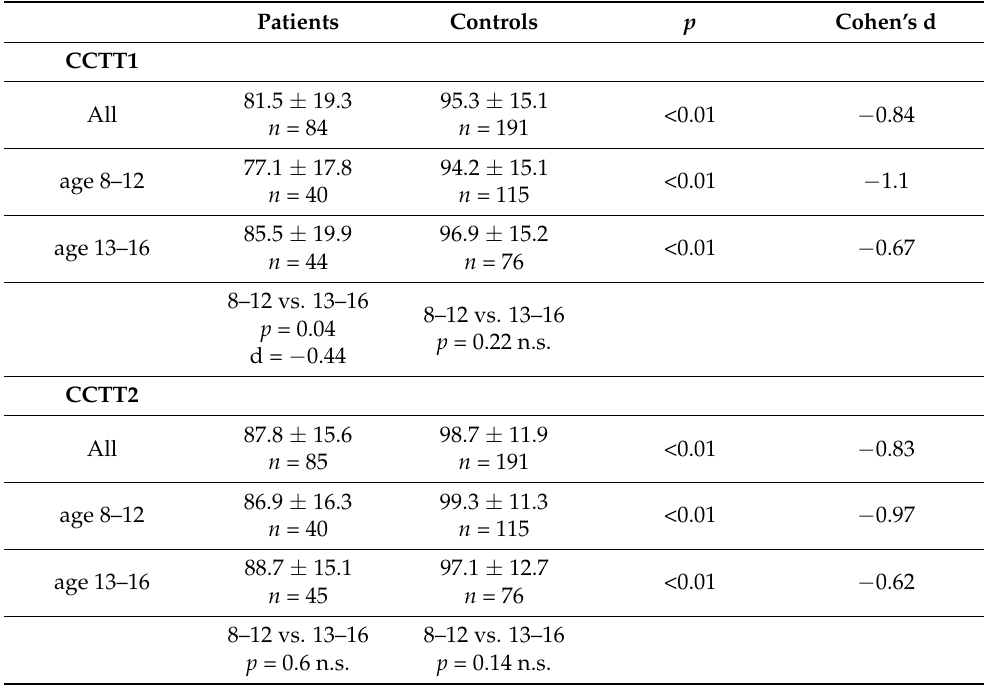
Table 3. Results of children’s color trail test (CCTT) in transplanted children and healthy controls.